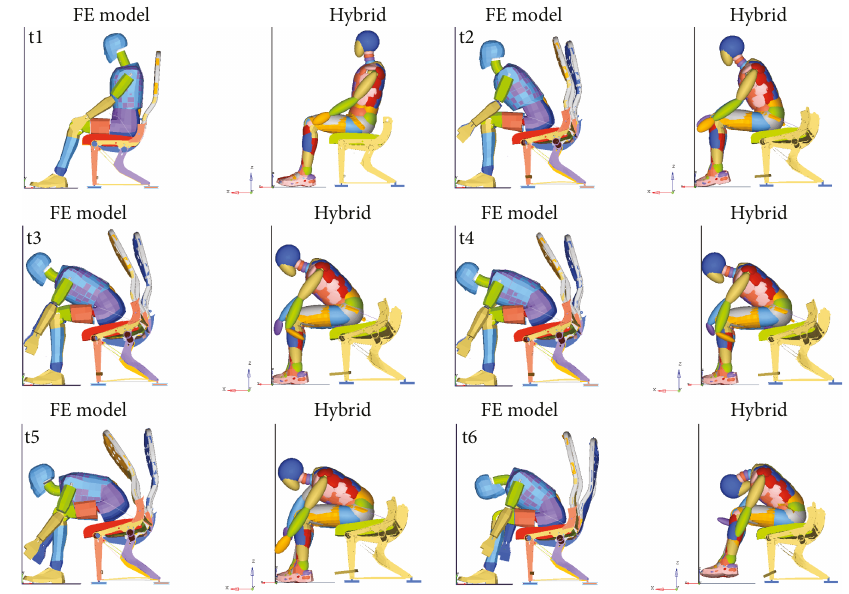
Figure 7: Full FE and hybrid model results.